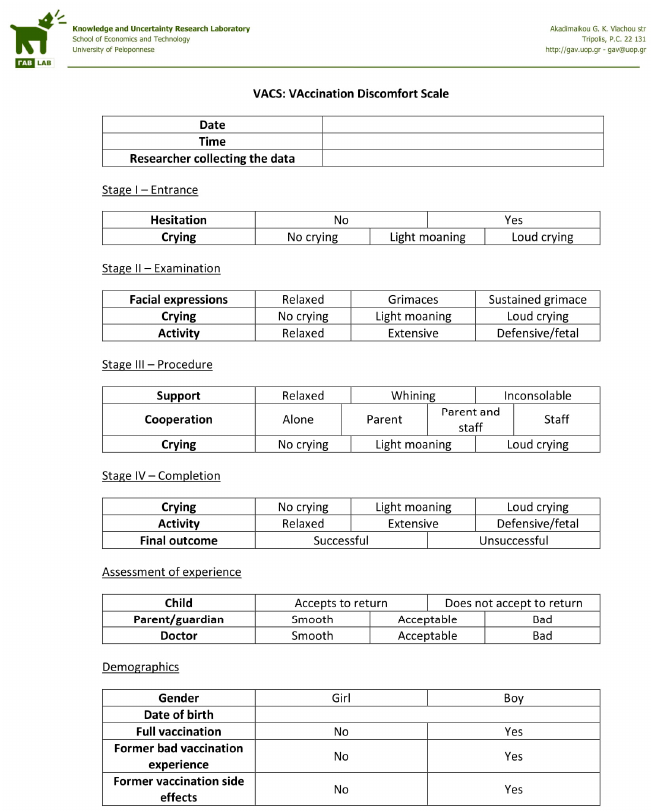
Figure A2. The form used to collect the data, translated into English.